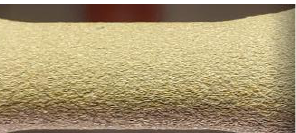
Figure 10. Sample G — unbroken after over 5 million cycles. σ = 318 MPa, n = 5,000,208 cycles.